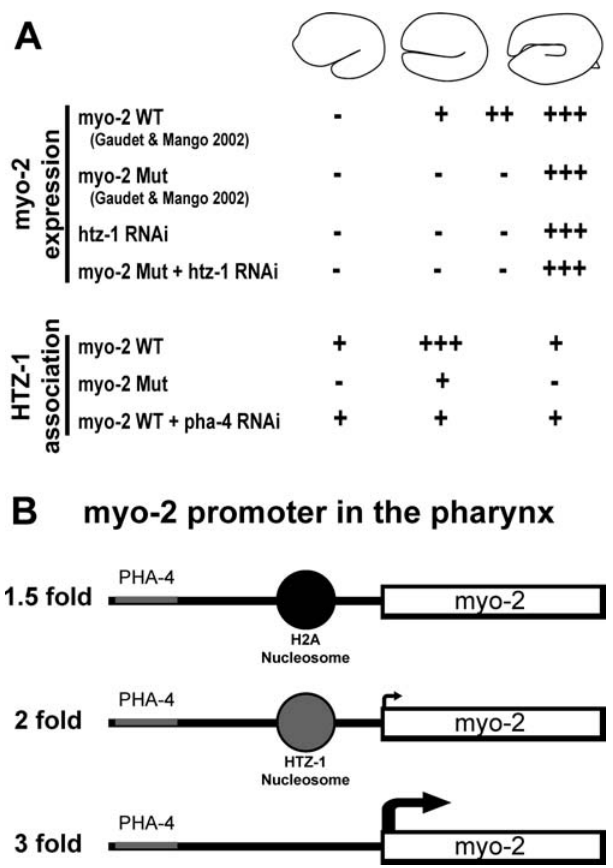
Figure 9. Summary and Model: HTZ-1 Synergizes with PHA-4 to Establish the Foregut (A) Summary of the data presented in this paper and in [18]. myo-2 expression initiates at the 2-fold stage, and onset at this stage requires pha-4 and htz-1 because mutation of PHA-4 binding sites (Mut) or htz-1 RNAi lead to a delay in myo-2 activation. HTZ-1 association with the myo- 2 promoter peaks at the onset of myo-2 transcription, and this association requires pha-4 . (B) Model to explain how HTZ-1 synergizes with PHA-4. PHA-4 association with the myo-2 promoter leads to exchange of H2A- containing nucleosomes for one or more nucleosomes carrying HTZ-1/ H2A.Z at the 2-fold stage. Based on data from other organisms [1], we propose MYS-1 and/or SSL-1 function in a complex that performs the exchange reaction. HTZ-1–containing nucleosomes promote transcrip- tional activation by the 2-fold stage. DOI: 10.1371/journal.pgen.0020161.g009